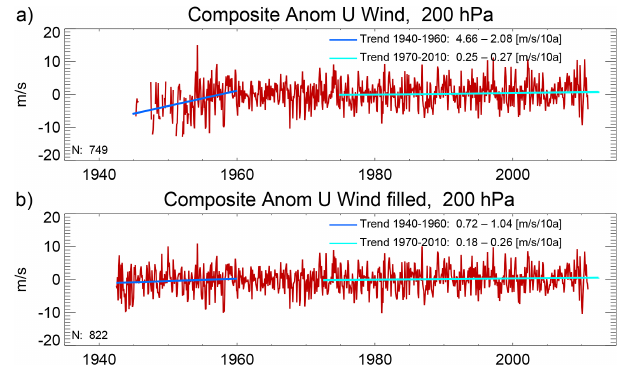
Figure 5. Monthly mean wind speed at 200hPa, averaged over WMO stations with IDs between 70000 and 75000 (mostly USA and Canada), (a) without filling, (b) with missing data replaced with NOAA-20CR scaled wind